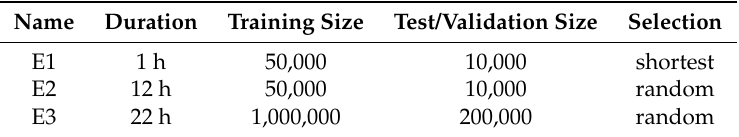
Table 1. Description of the datasets used in the experiments. Name: Dataset identifier. Duration: Time used for training the models. Training size: Number of samples used for training. Test/validation size: Number of samples used for test and for validation. Selection: Sample selection